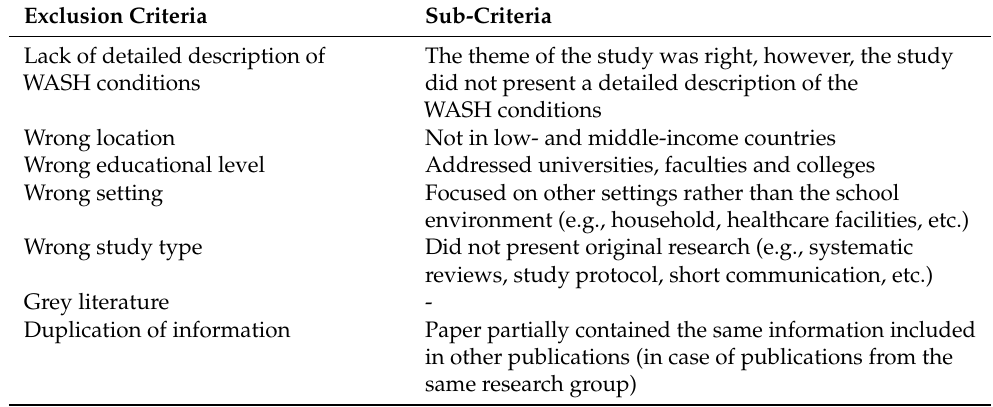
Table 1. Exclusion criteria for the systematic literature review on WASH in schools in low- and middle-income